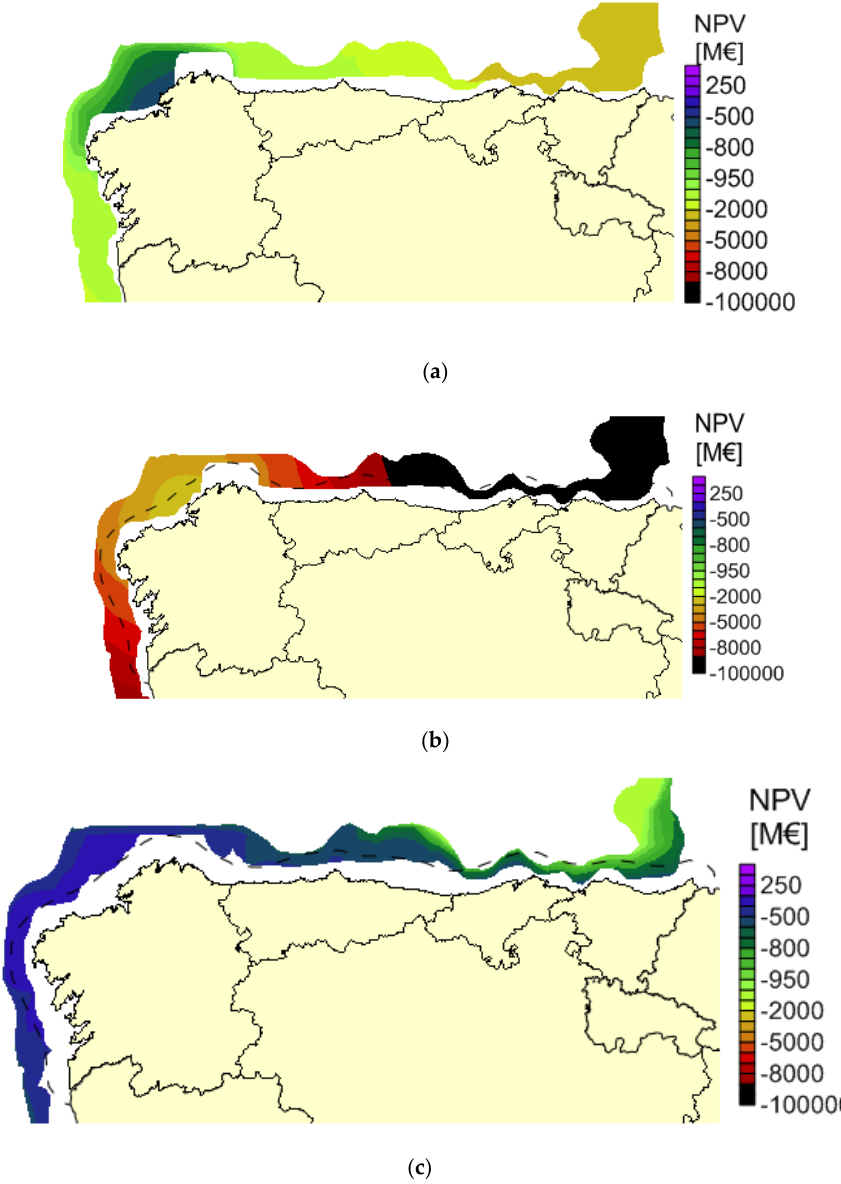
Figure 13. Outputs for net present value studying a 600 €/MWh tariff and a depth restriction for D1 ( a ), D2 ( b ) and D3 ( c ).